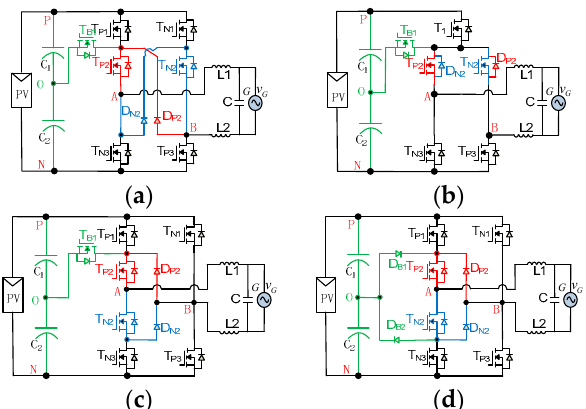
Figure 10. Indirect Connection NPC topologies from M = 3, N = 3. ( a ) R6S1 [51]; ( b ) R7S1 [19]; ( c ) R8S1-1 [51]; ( d ) R8S1-2 [48].